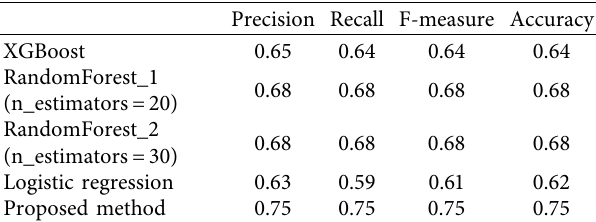
Table 7: Result for class 1 in UAL dataset.